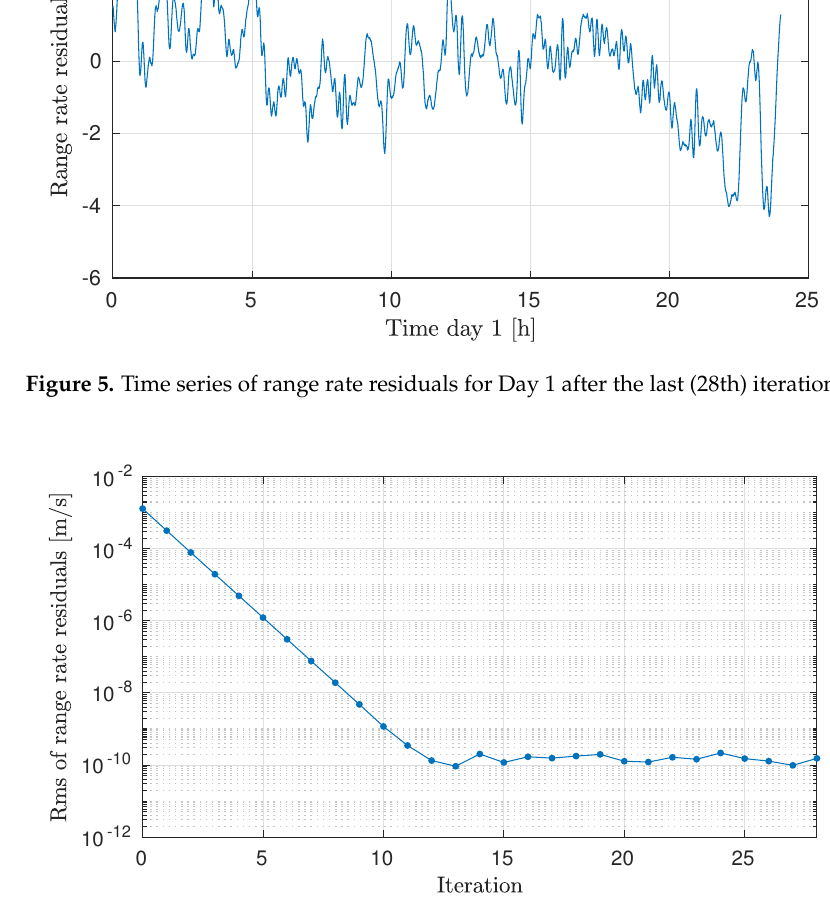
Figure 6. Root mean square (rms) of range rate residuals for Day 1, for each iteration Additionally, in Figures 7 and 8, the amplitude spectral density (ASD) of the range rate residuals are plotted. For the first iterations, two dominant peaks of one orbit and double orbit frequencies are visible. With further iterations, these peaks are decreasing more and